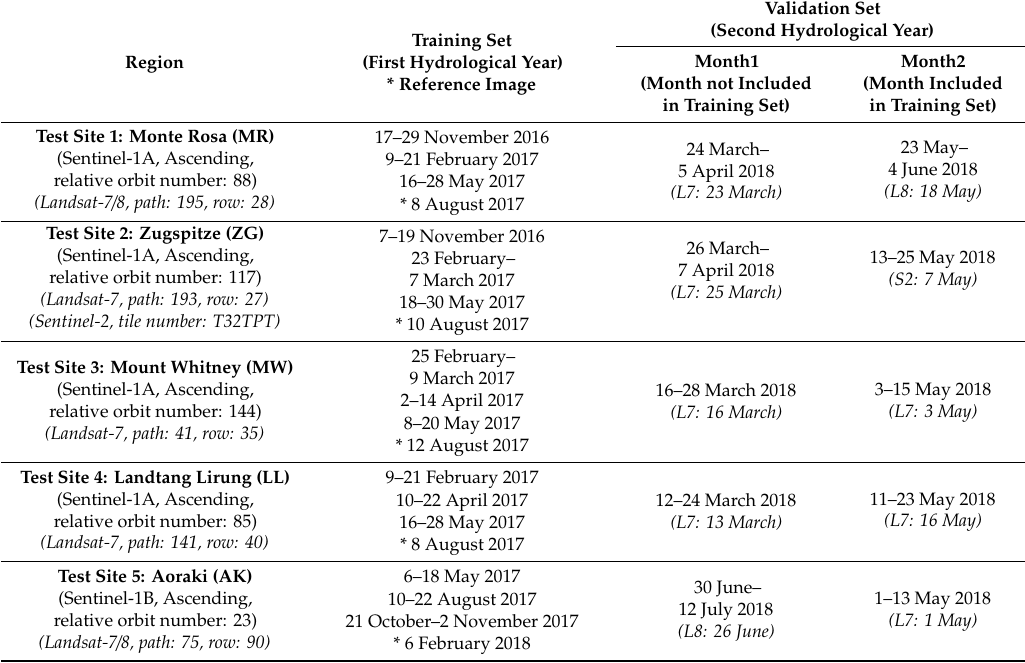
Table 2. Summary of the synthetic aperture radar (SAR) data (Sentinel-1) and optical data (Sentinel-2, S2; Landsat-7 / 8, L7 / 8) used in the training and validation set. Note: the reference image of each region for calculating the wet snow cover extent (SCE) is marked with an asterisk (*); optical images employed in the validation set are included in brackets below the used SAR image